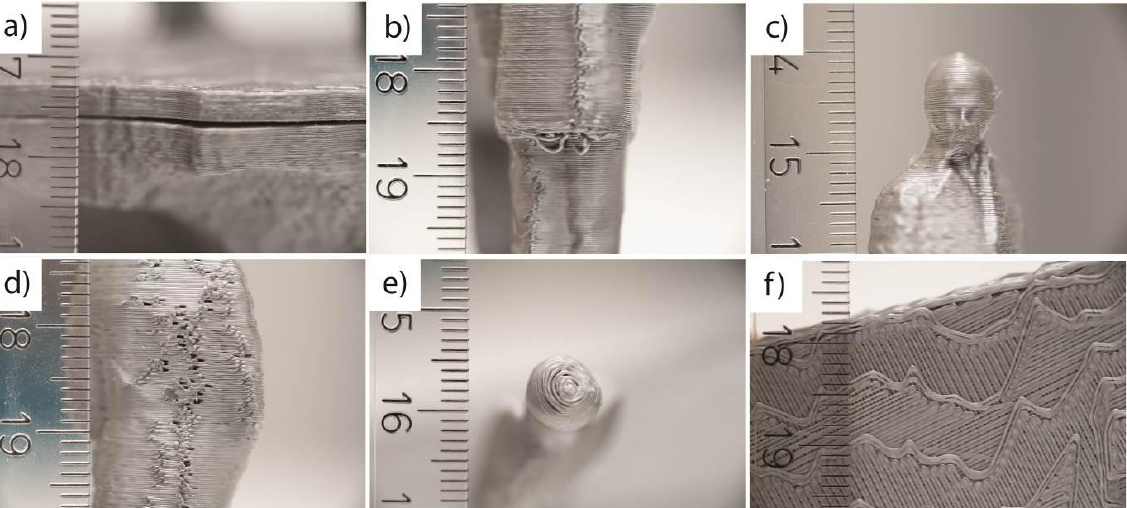
Figure 11. Different artifacts caused by RP machines: ( a ) Seam; ( b ) Hanging layers; ( c ) Visible layers; ( d ) Gaps in layers; ( e ) Over/under extrusion; ( f ) Step pattern.